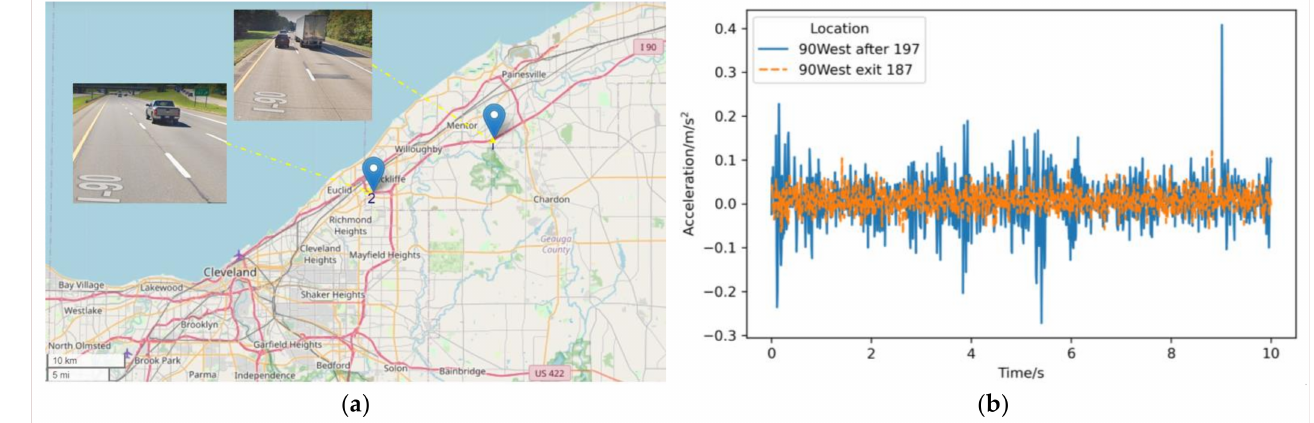
Figure 11. In situ vehicle vibration testing of the field pavement: ( a ) geographical location of the in situ testing; ( b ) field acquisition of raw vibration